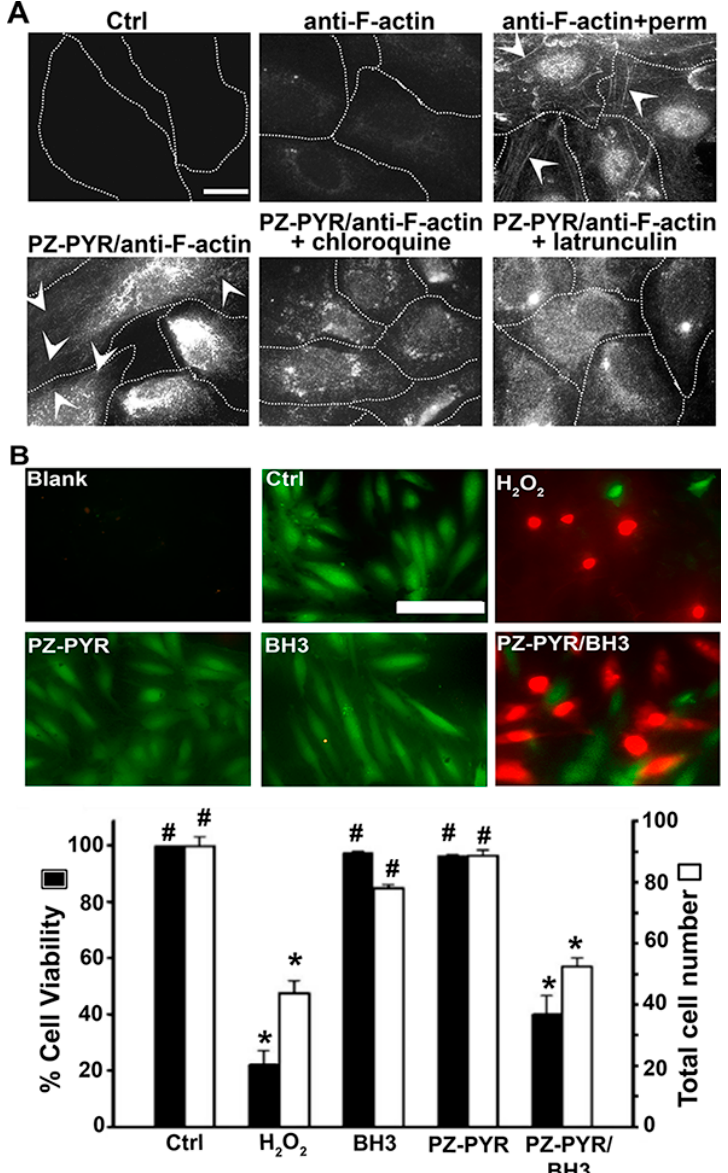
Figure 6. Cytosolic delivery of active proteins by PZ polymer. ( A ) HUVECs were incubated for 1 h at 37 °C with control medium (Ctrl), anti-F-actin antibody alone or PZ-PYR/anti-F-actin, in the absence or presence of chloroquine (to inhibit endo-lysosomal acidification) or latrunculin (to inhibit polymerization of F-actin), followed by content removal and 4 h incubation with fresh cell medium. Post permeabilization of cells, F-actin was stained using a fluorescent secondary antibody and visualized by fluorescence microscopy. Anti-F-actin + perm. is a control where anti-F-actin was incubated with cells previously permeabilized. Arrowheads = actin fibers. Scale bar = 10 µ m. ( B ) HUVECs were incubated for 1 h at 37 ◦ C with control medium (Ctrl), H 2 O 2 to induce cell death, PZ-PYR polymer alone, and Bax-BH3 peptide alone or complexed to PZ-PYR, followed by content removal and 4 h incubation with fresh cell medium. Staining with the live-dead viability reagent was conducted to stain live cells in green and dead cells in red, for fluorescence microscopy visualization. Scale bar = 50 µ m. Total number of cells per image (white bars) and % viability expressed as the percentage of live cells among total cells (black bars). Data are mean ± SEM. * p < 0.05 relative to the untreated control, # p < 0.05 relative to H 2 O 2 To further verify whether other protein cargoes can be delivered to the cell cytosol by PZ-PYR, the pro-apoptotic Bax-BH3 peptide was chosen. The molecular targets of Bax-